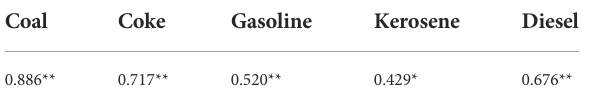
TABLE 1 Correlation coef fi cients between BC concentration and different fossil fuels consumed from 1995 to 2019.